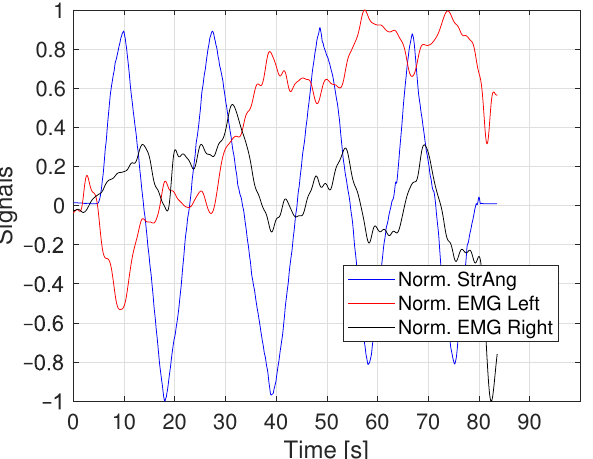
Figure 9. Normalized EMG activity Deltoideus Anterior (DA) (front shoulder) muscle over time.